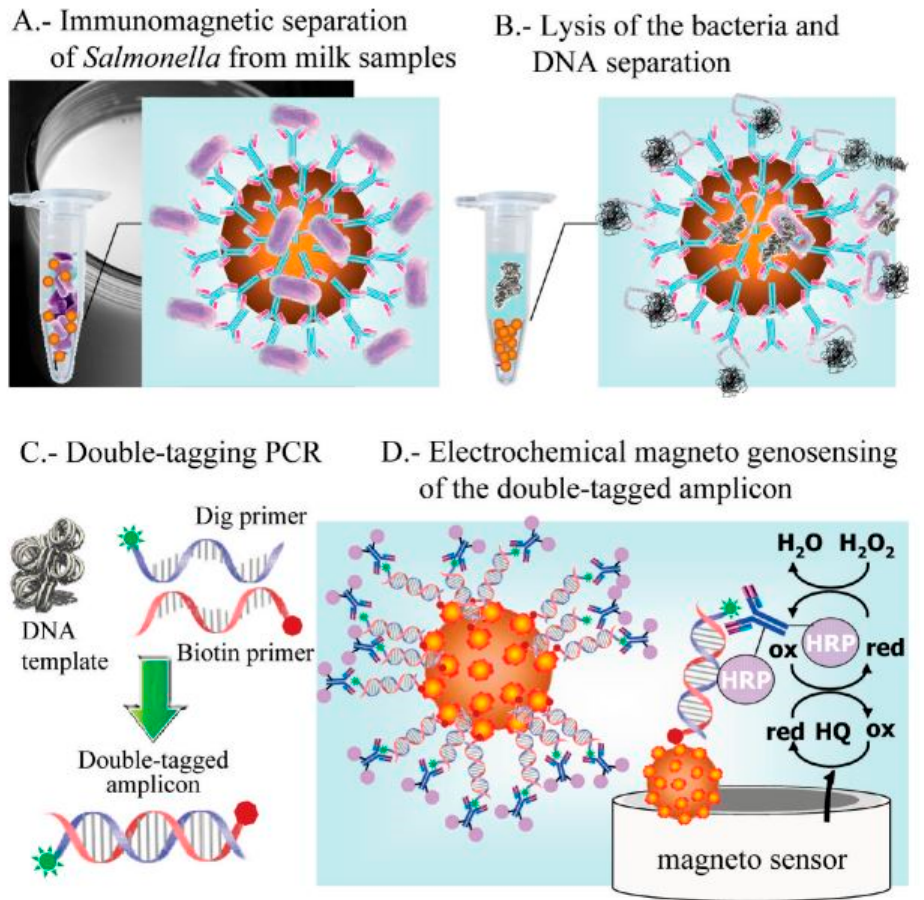
Figure 5. Electrochemical genosensing using immunomagnetic separation (IMS)/double-tagging PCR/m-GEC technique. ( A ) Separation of Salmonella contamination using Immunochromatographic separation in milk samples; ( B ) Bacterial lysis and separation of the nuclei acid; ( C ) Double-tagging of the nucleic acids; ( D ) Electrochemical genosensing (GEC) of double-tagged amplicon or the nucleic acid. Adapted with permission from Ref. [84]. Copyright 2009, American Chemical Society.